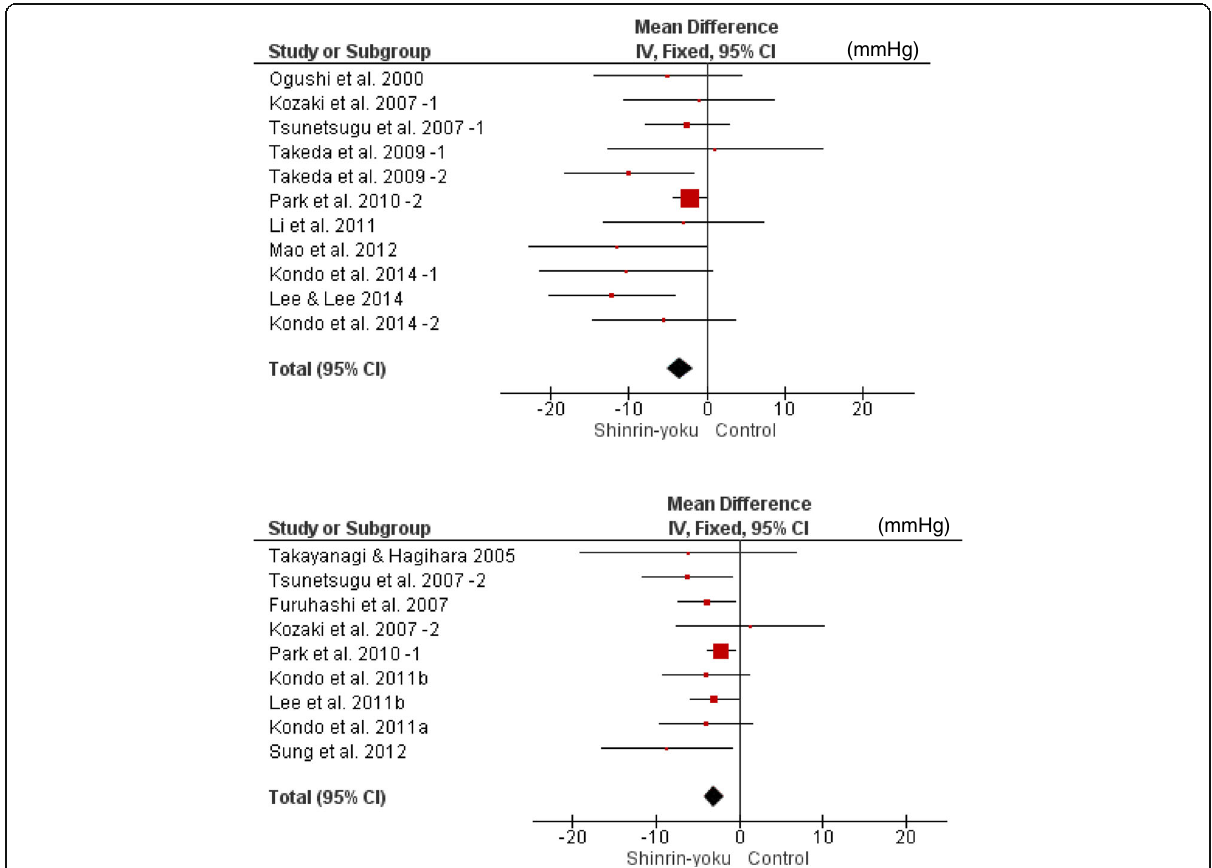
Fig. 4 Two forest plots of the change in SBP (mmHg) in the two subgroup analyses of differences in intervention methods (walking and non- walking). 1) Walking group. 2) Non-walking group. CI, confidence